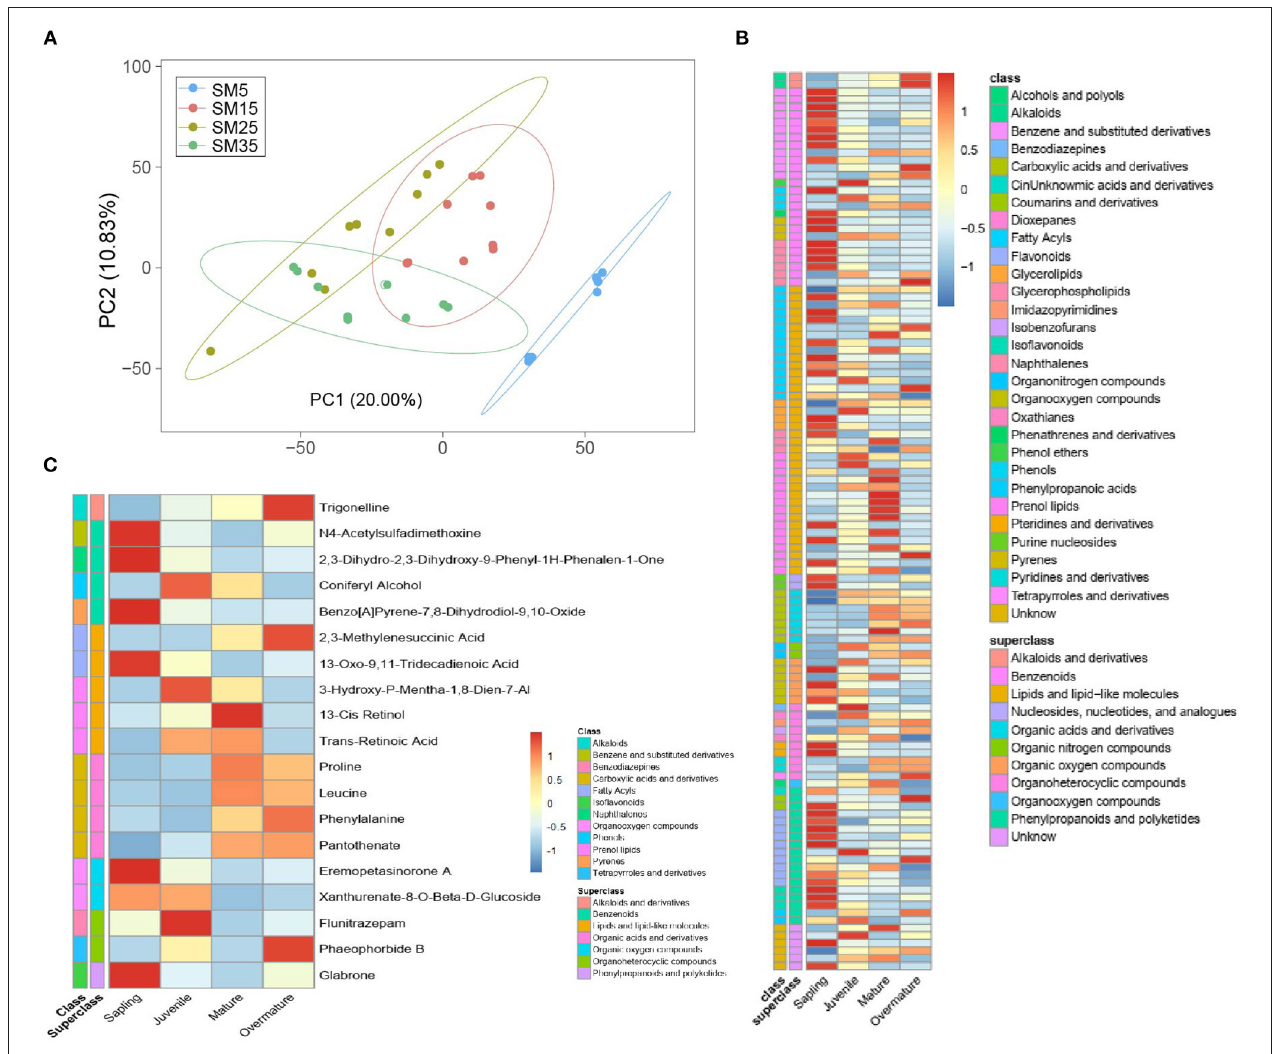
FIGURE 7 | Metabolites that showed a significant change between any two stands of Chinese fir as indicated by partial least-squares discriminant analysis. (A) Principal component analysis (PCA) of the foliar metabolites of 28 independent samples collected from Chinese fir aged 5, 15, 25, and 35 years; (B) heatmap for all significantly changed metabolites. Metabolites satisfied the following conditions in pairwise comparisons: (1) ratio ≥ 2 or ratio ≤ 0.5; (2) q value < 0.05; (3) VIP ≥ 1; (4) annotation with a secondary metabolite; (C) level of metabolites that significantly changed at least four times in six pairwise